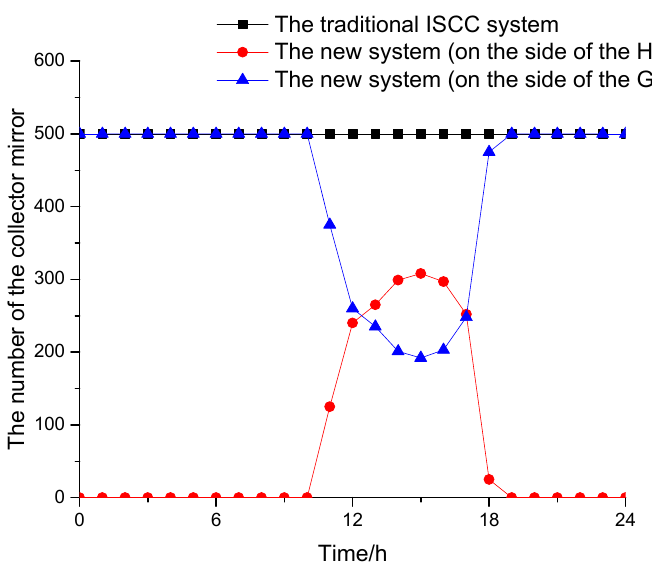
Figure 8. The number of collector mirrors in a typical summer day.